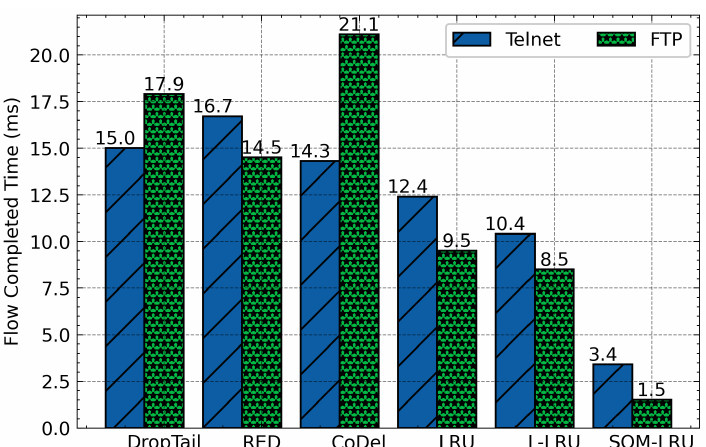
Figure 12. Average throughput comparison.